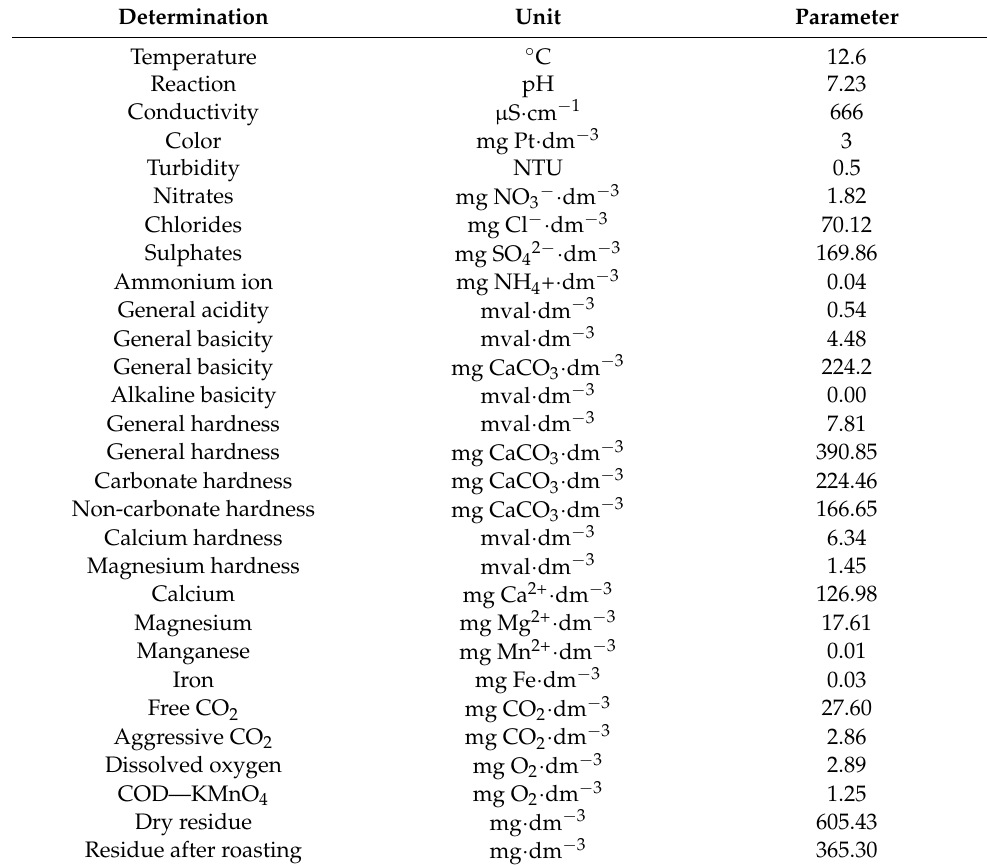
Table 1. Physical and chemical characteristic of the water transported by the investigated